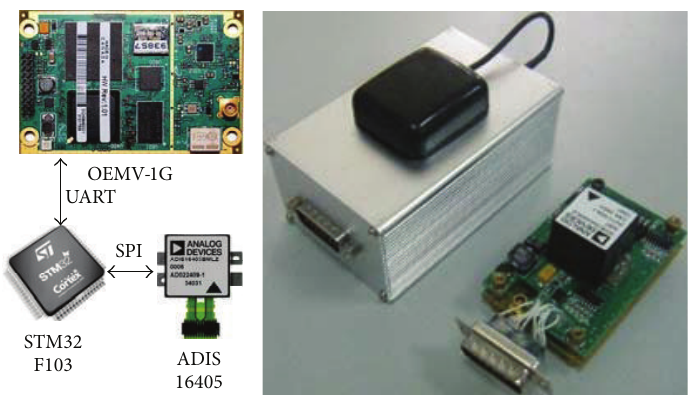
Figure 1: The realized navigation